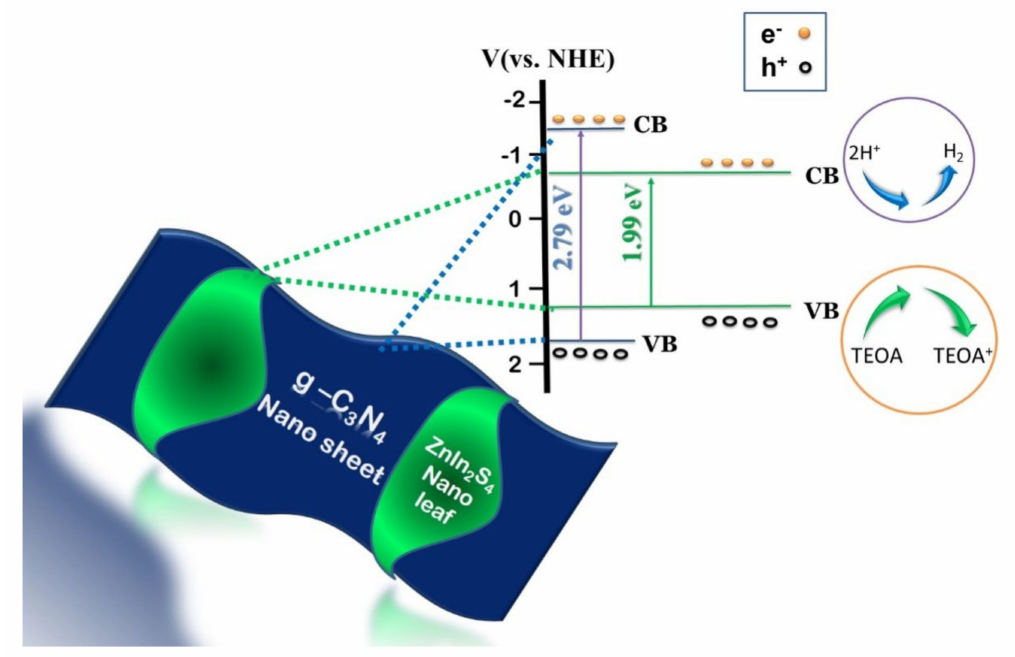
Figure 3. Schematic representation of in-situ growth of ZnIn 2 S 4 nano leaves over g-C 3 N 4 nanosheet. Figure adapted from